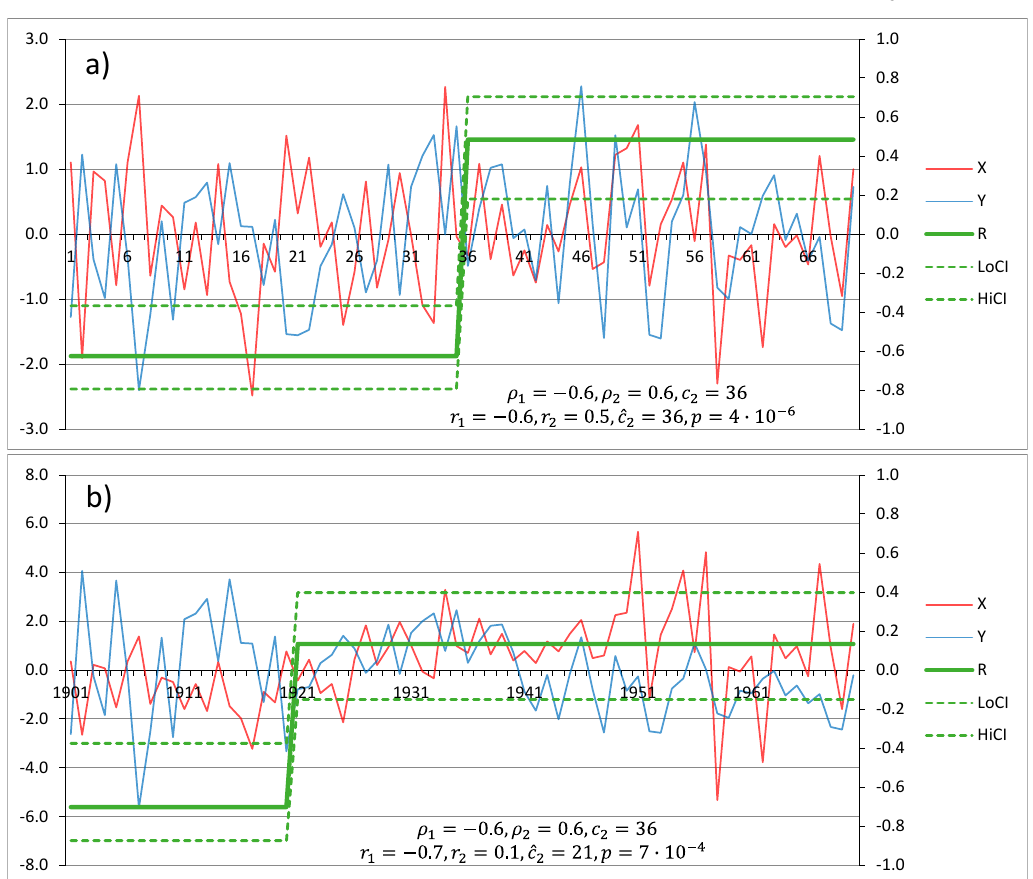
Figure 4. Regime shifts in the correlation coefficient ( a ) correctly detected at 𝑖 = 36, after shifts in the mean and variance are removed; and ( b ) a spurious shift at 𝑖 = 21, when the SRSD is applied directly to the original series in Figure